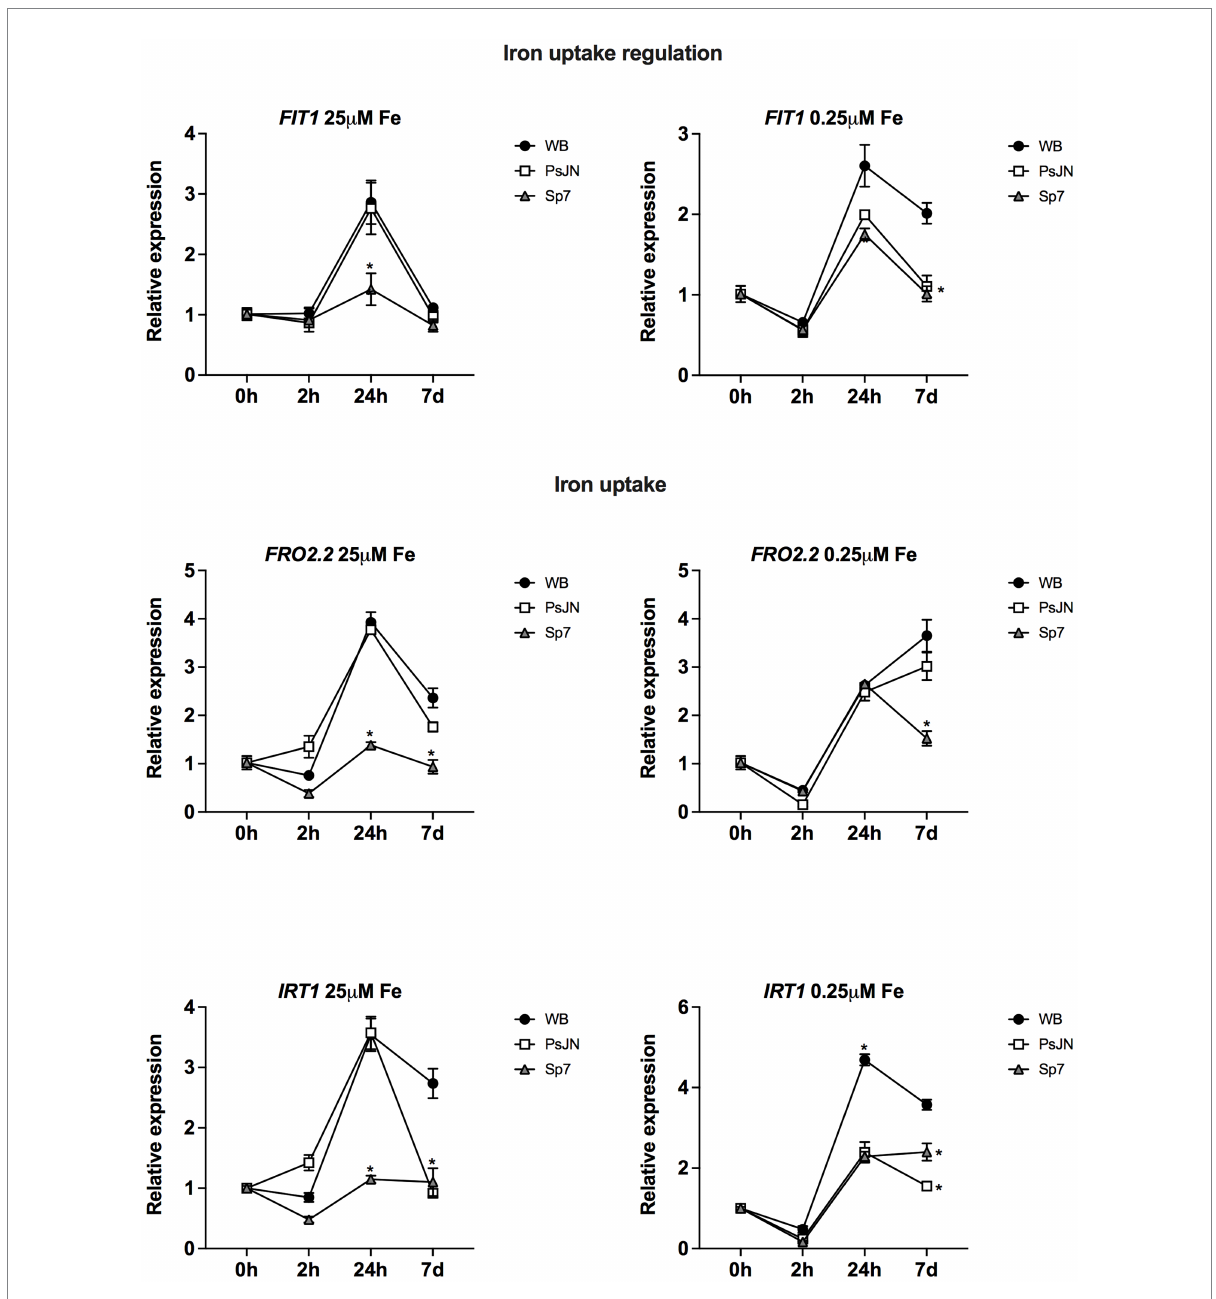
FIGURE 9 Effects of beneficial bacteria on iron uptake-related genes in Arabidopsis thaliana grown in different phosphate sources. Quantitative RT-PCR determinations of relative expression levels of the genes related to iron uptake regulation FIT1 ( ARABIDOPSIS FE-DEFICIENCY INDUCED TRANSCRIPTION FACTOR 1 ); and uptake FRO2.2 ( FERRIC REDUCTASE OXIDASE 2.2 ) and IRT1 ( IRON-REGULATED TRANSPORTER 1 ). Plants were exposed to 25 μ M FeSO 4 /0 μ M Fe 2 (SO 4 ) 3 as a highly soluble iron source (left panel) or 0.25 μ M FeSO 4 /24.75 μ M Fe 2 (SO 4 ) 3 as an iron source with low solubility (right panel) for 0, 2, 24 h or 7 days (d). Simultaneously, plants were non-inoculated (WB) or inoculated with Paraburkholderia phytofirmans PsJN (PsJN) or Azospirillum brasilense Sp7 (Sp7). Normalization was performed with the housekeeping SAND family gene (AT2G28390). Asterisks indicate statistical significance among treatments in a particular time compared to the WB group (Two-way ANOVA and multiple comparisons, p <